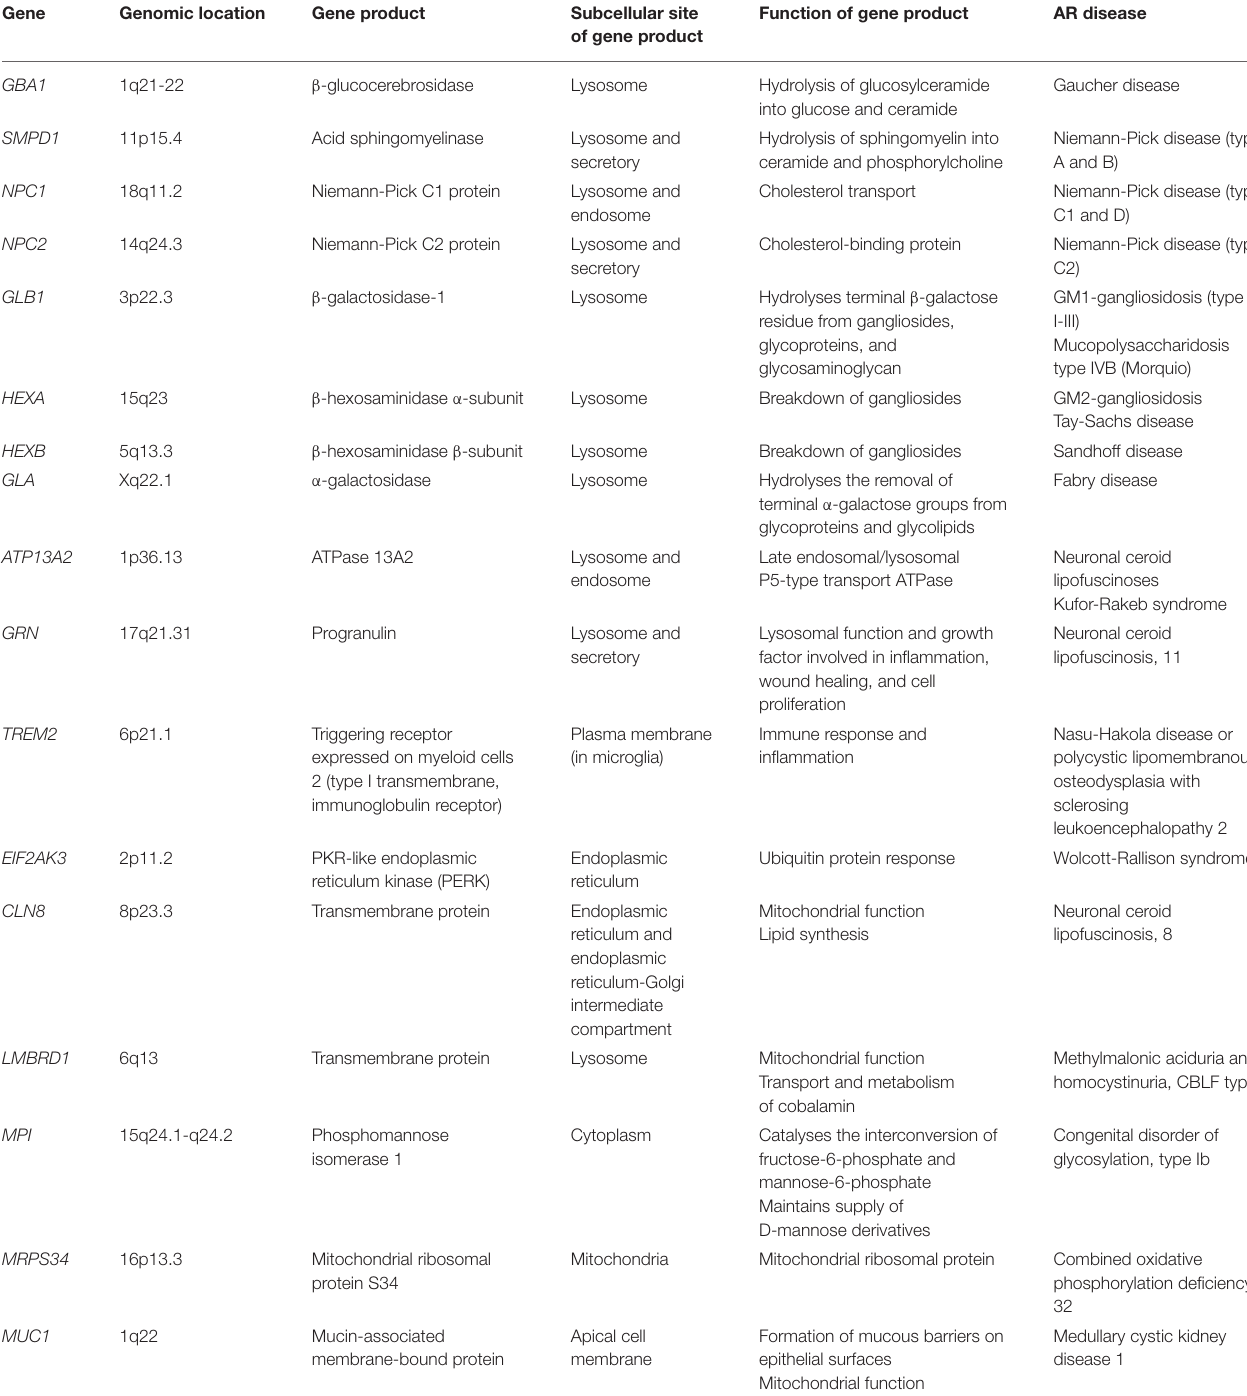
TABLE 1 | Structure and function of genes involved in both AR disease and neurodegeneration.